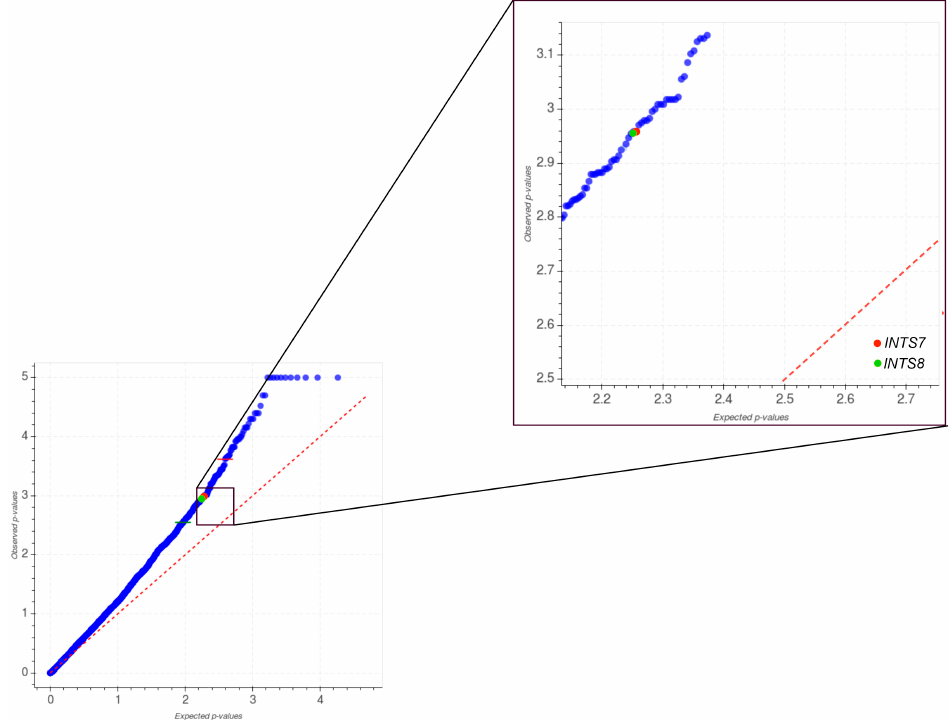
Figure 3. Quantile–quantile (QQ) plot comparing the expected and observed distribution of functional mutation (FM) bias p -values of genes detected in the UCEC cohort. Blue dots indicate genes reporting at least one somatic mutation in UCEC Exome-Seq data. Red dotted line indicates coincident values of expected and observed distributions of p -values. INTS7 and INTS8 genes are highlighted in red and green, respectively.